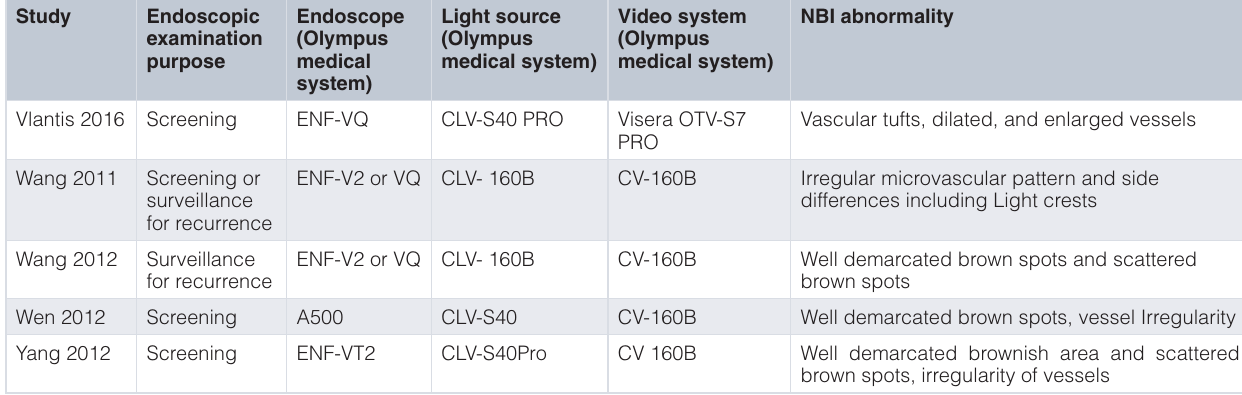
Table 2. Endoscope examination